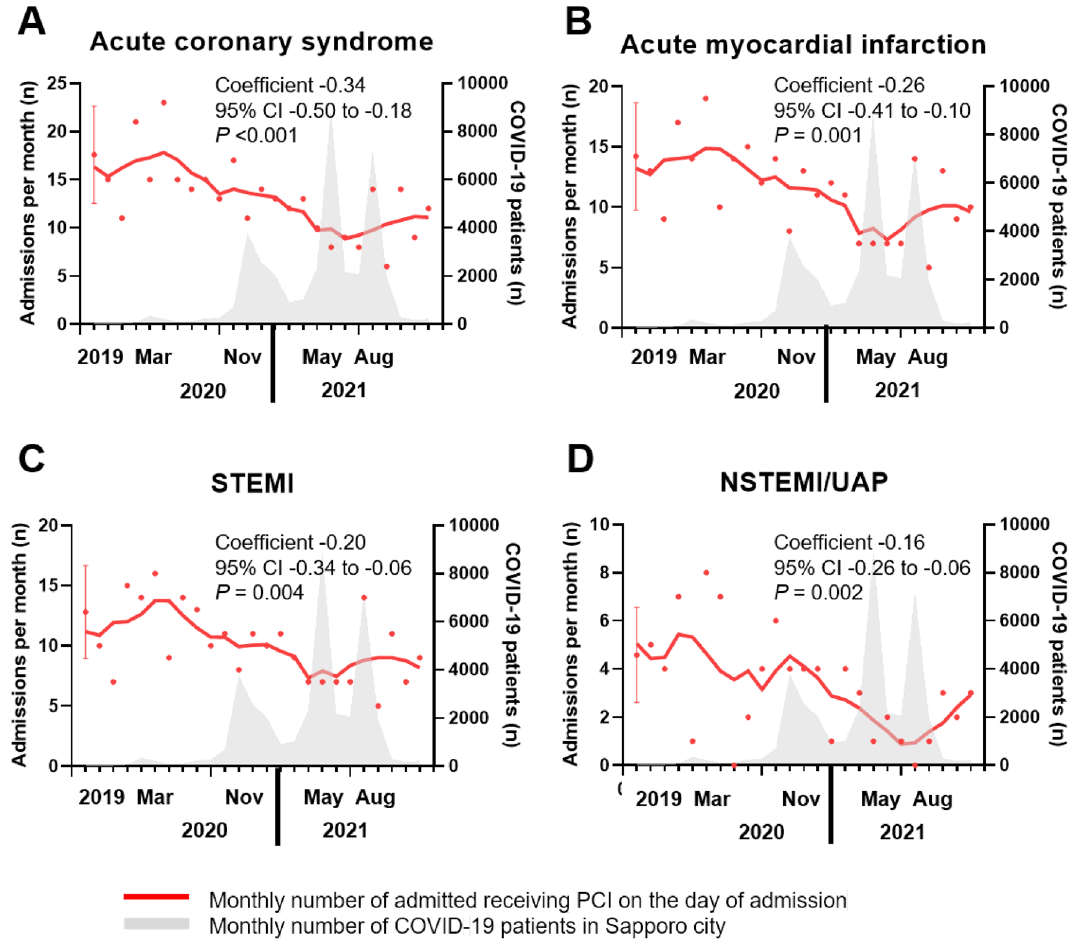
Figure 2. Monthly number of patients admitted via the EMS to Sapporo ACS network hospitals with acute coronary syndrome, by type. ( A ) Acute coronary syndrome, ( B ) acute myocardial infarction, ( C ) STEMI, ( D ) NSTEMI/UAP. The gray area indicates the monthly number of COVID-19 patients in Sapporo city. COVID-19 coronavirus disease-2019, NSTEMI non-ST elevation myocardial infarction, STEMI ST elevation myocardial infarction, UAP unstable angina